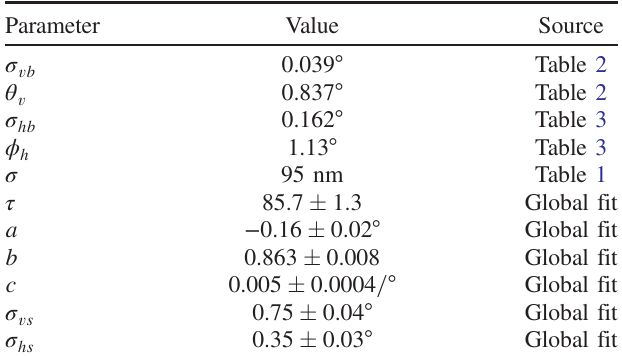
TABLE VIII. Model parameter values used for global fit to the angular distribution data. For the fitted parameters, the standard errors from the fit are given. In addition, for each of the ϕ fits, an overall offset of the center of the model distribution from the ϕ ¼ 0 point was allowed as an additional free parameter. These offsets, which ranged from − 0 . 01 ° to − 0 . 11 °, are not shown in the table. Parameter